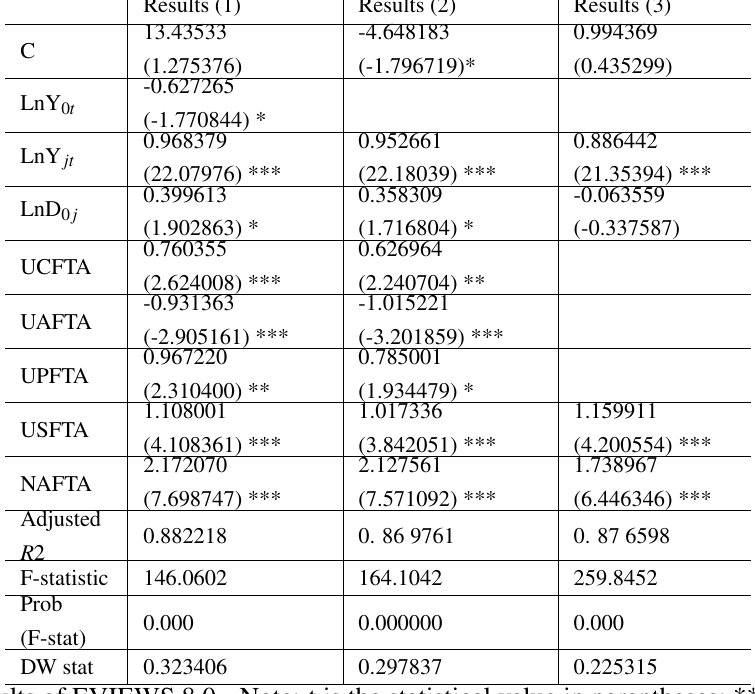
Table 1 Results of regression analysis considering only economic variables.